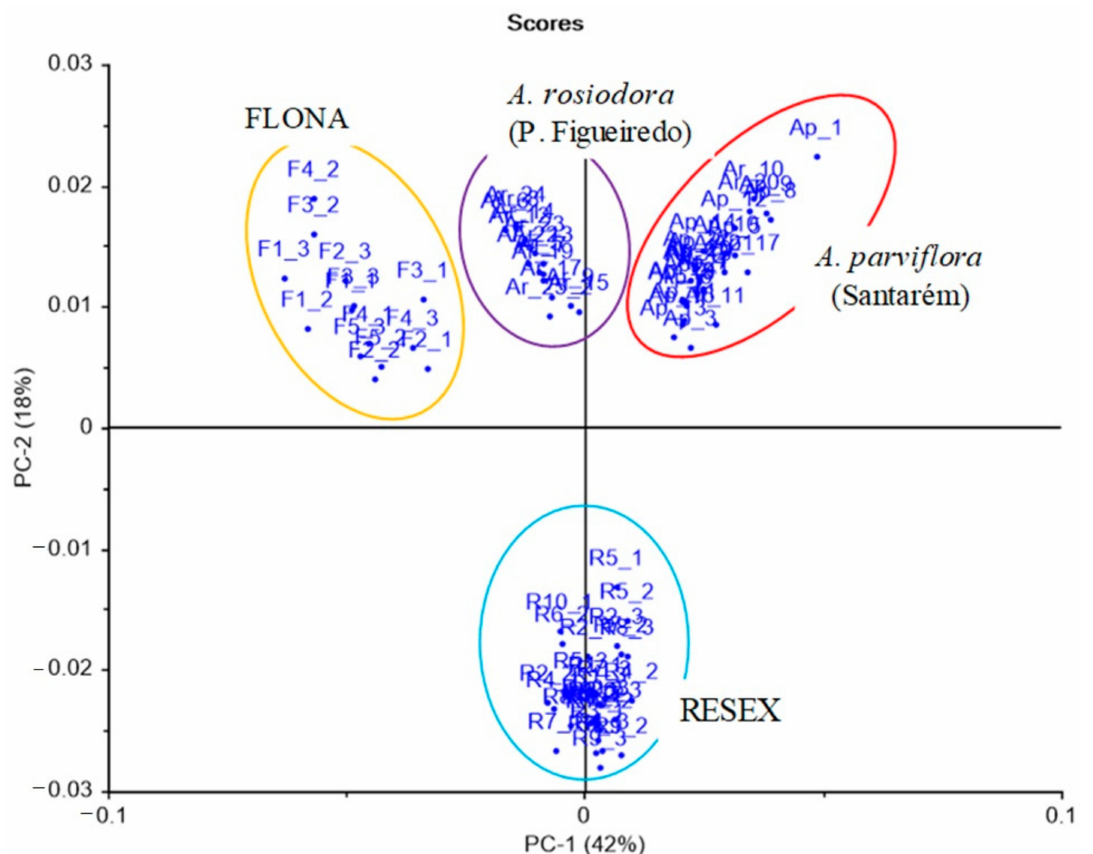
Figure 5. The score plot of the first two PCs of 1 H-NMR data of A. rosiodora samples from RESEX (R), FLONA (F) and Presidente Figueiredo (Ar), and A. parviflora (Ap) (Santar é m, PA), representing the chemical profile variance in A. rosiodora collected in different localities.